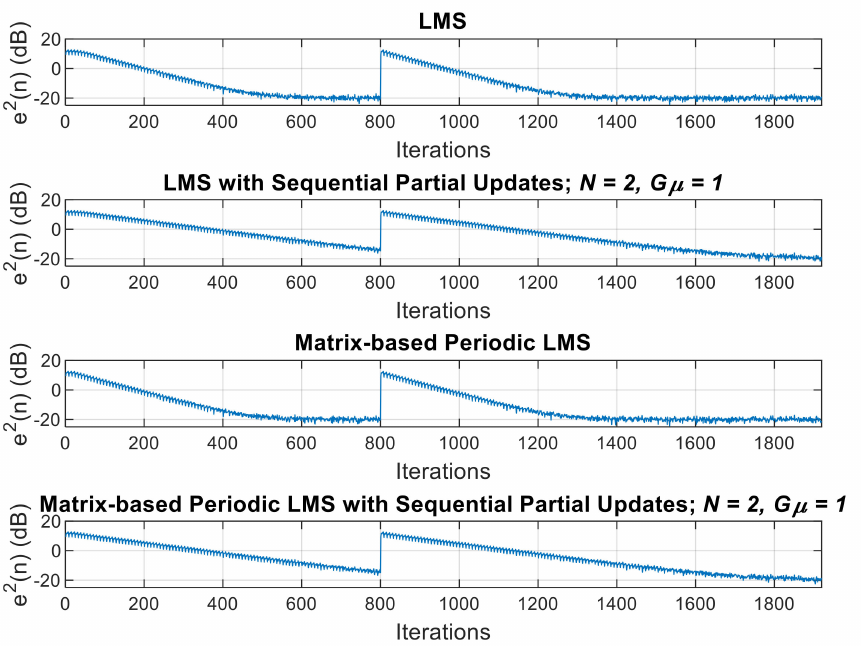
Figure 13. Learning curves comparison. Version 2 of the experiment: desired signal d 2 ( n ) and reference signal x 2 ( n ) . ( a ) LMS, ( b ) LMS with Seq PU; N = 2 and G µ = 1, ( c ) P-LMS, ( d ) P-LMS with Seq. PU; N = 2 and G µ = 1. Average of 50 runs. The performance measure used is the instantaneous squared error in logarithmic scale